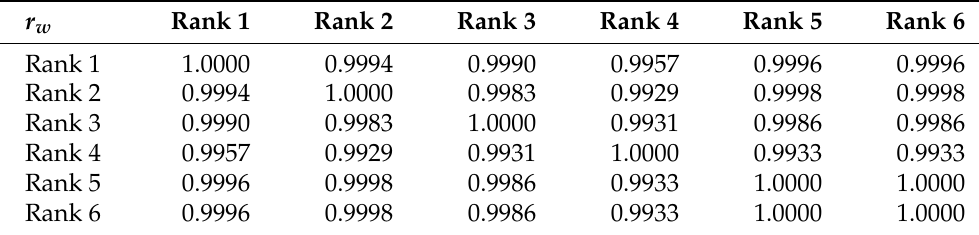
Table 19. Correlation matrix for r w values for candidate compromise rankings with consideration of the whole dataset.